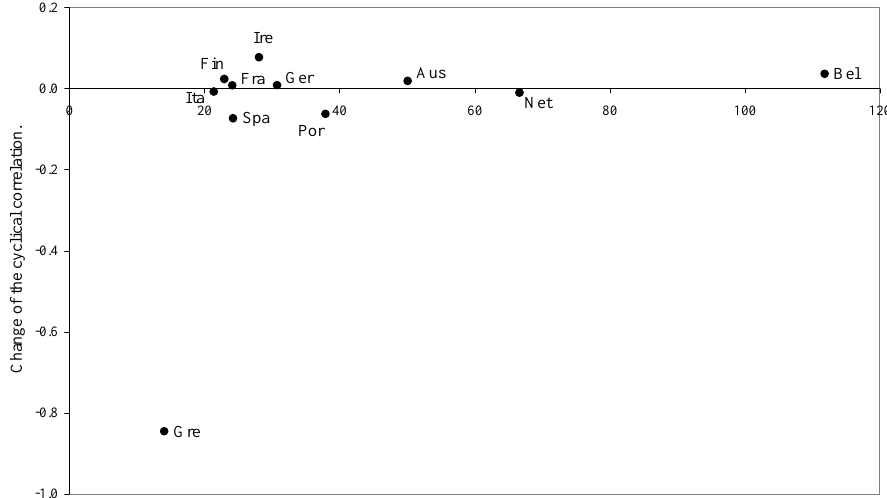
Table 1 three variants of the correlation coefficient were computed: with the data of all the member states in the sample (eleven countries), without Greece (ten countries) and without Greece and Ireland